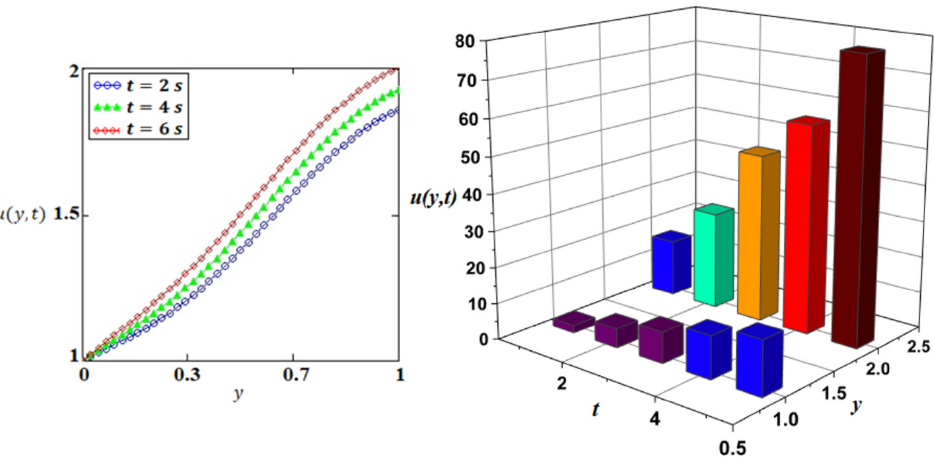
Figure 1. Graphical illustration of fractional approach of Caputo-Fabrizio with R 0 = 1, K 0 = 0.9, ZT 0 = 2, ω = 0.5, M = 0.1, α = 0.6, Pr = 15 for different time parameter values.